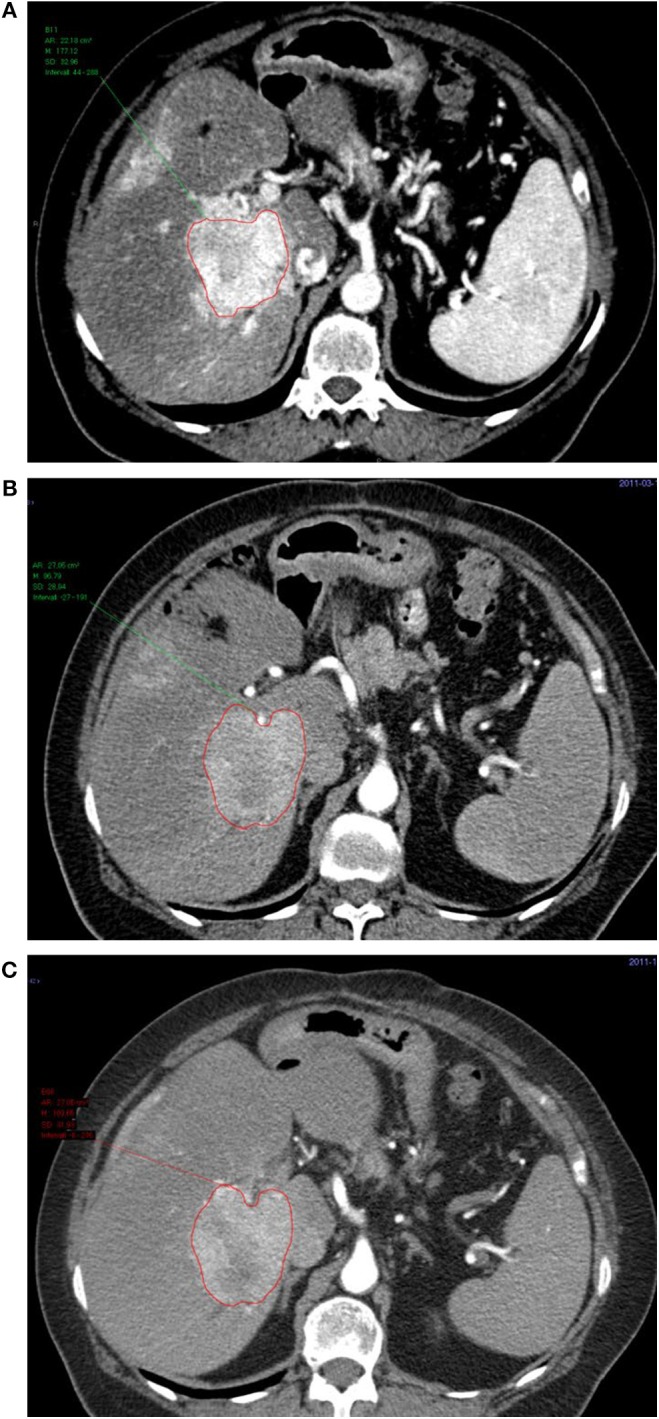
Transversal contrast-enhanced CT images in the arterial phase of a liver metastasis at baseline (A), before the 3rd cycle of treatment (B), and at follow-up (C).